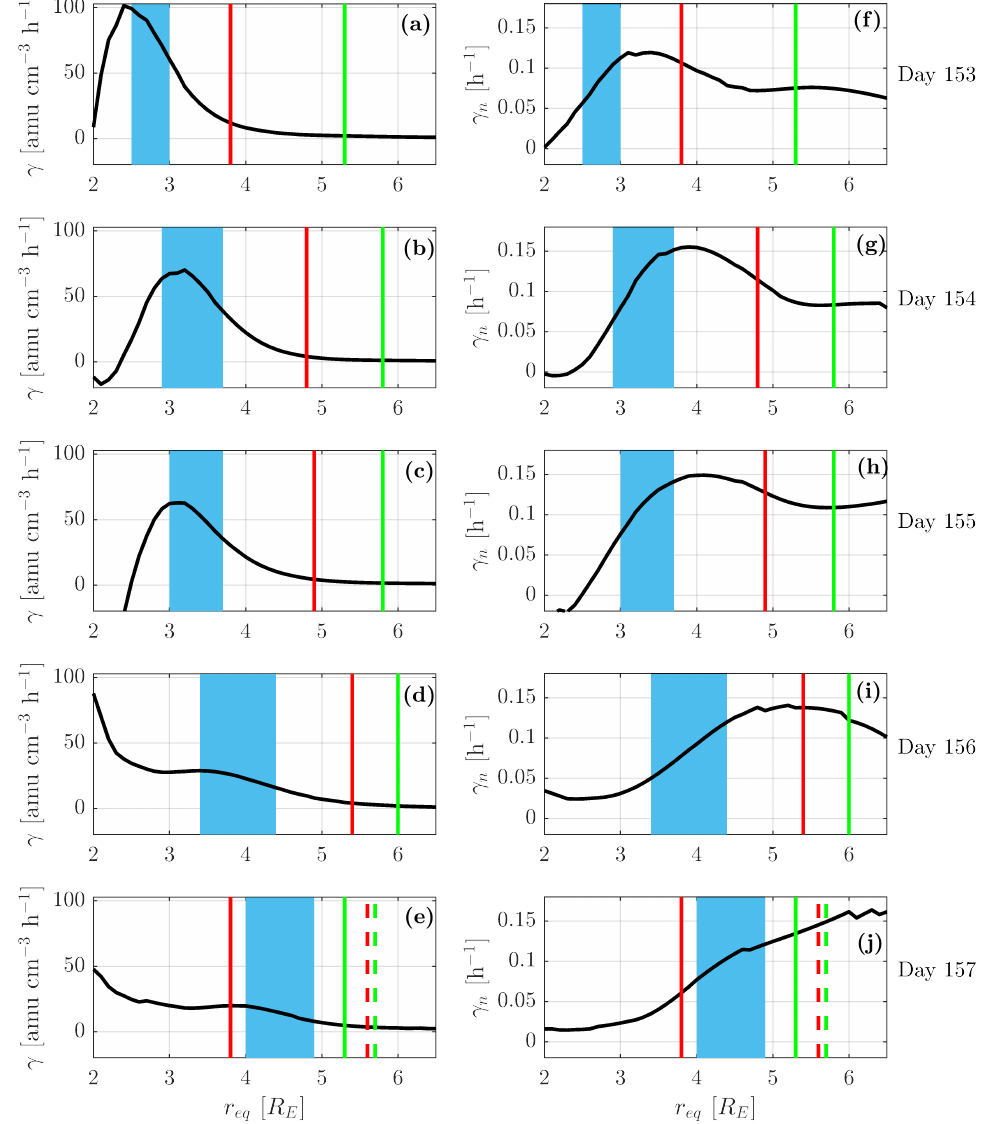
Figure 10. Radial profiles of the diurnal refilling ( a – e ) and of the normalized diurnal refilling rate ( f – j ) during the recovery phase. The light blue stripes represent the average PBL position for the days indicated to the right. The red and green lines are the average diurnal ZEAB position determined on the same days from the VSMC and E5D electric potential, respectively. The dashed lines are the average ZEAB position across the midnight sector, between days 156 and